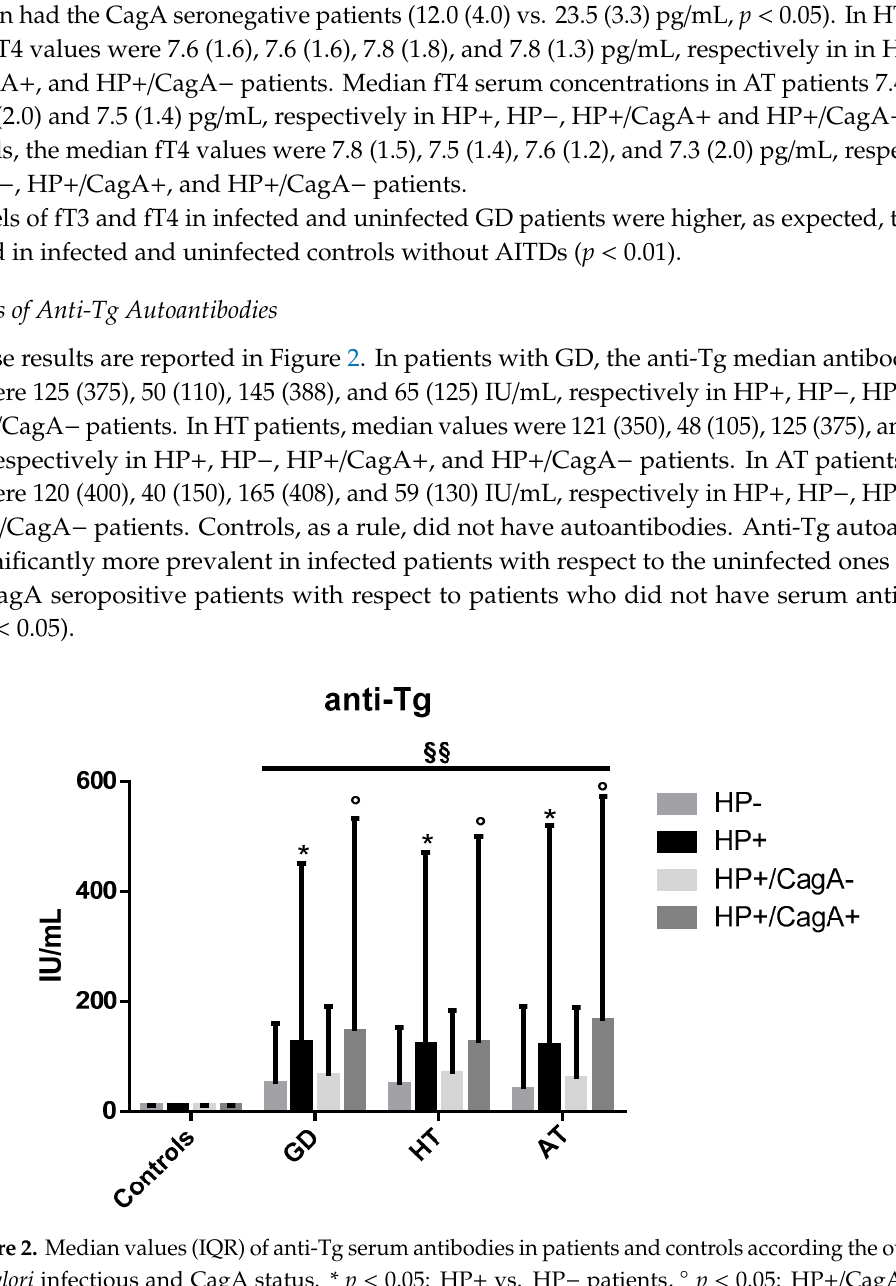
Figure 1. Median (IQR) values of fT3 ( left and fT4 ( right ) in patients with different clinical forms of AITD and controls according to the overall H. pylori and CagA infectious status. ° p < 0.05: HP+/CagA+ vs. HP+/CagA − , §§ p < 0.01 AITDs vs. no-AITDs.